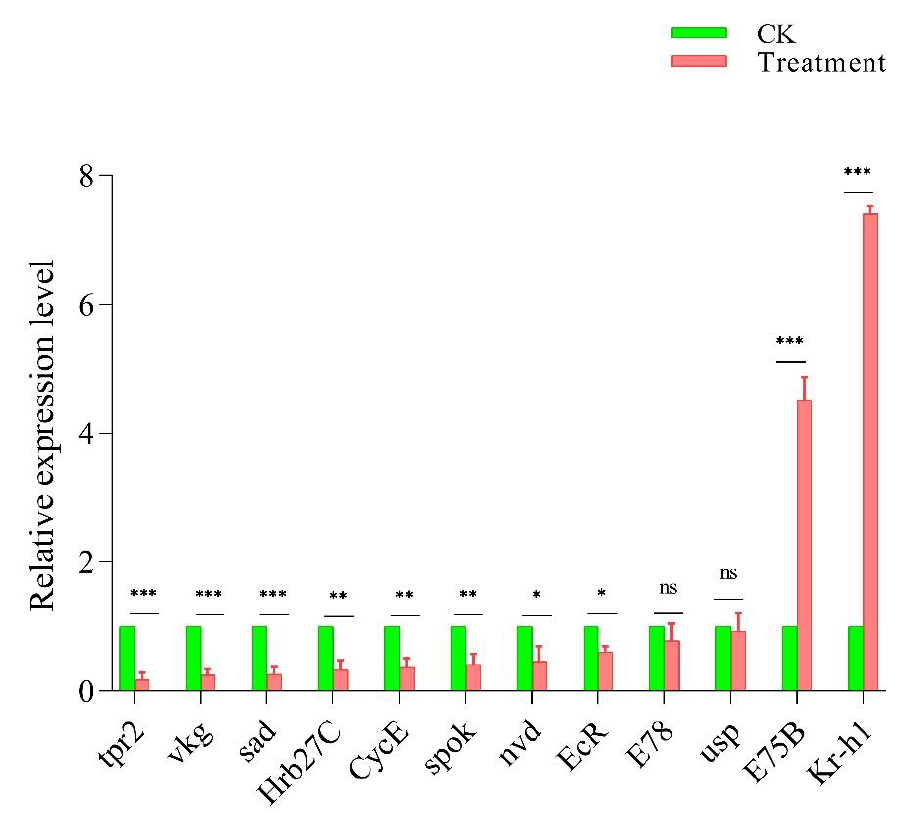
Figure 4. Expression of ecdysone signaling-related genes against cyromazine treatment. Error bars indicate 95% confidence intervals (CI). The p -value of Student’s t -test is: * p < 0.05; ** p < 0.01; *** p < 0.001; ns not significant.